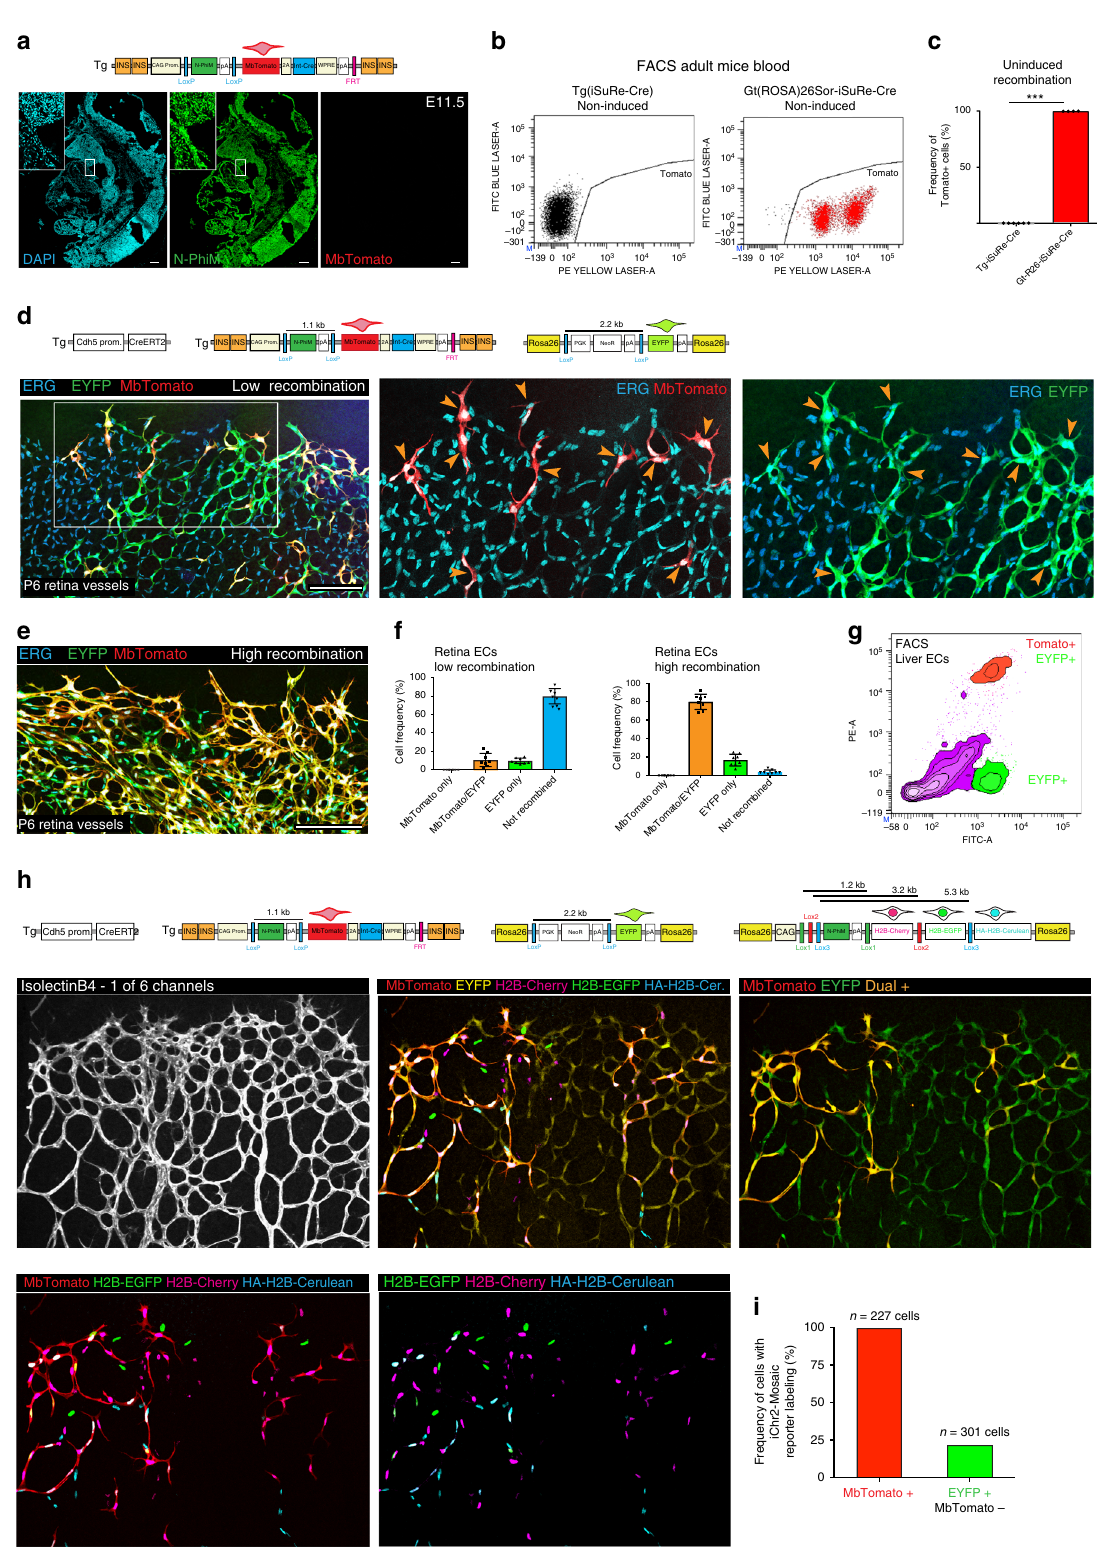
spontaneous deletion of these genes in a fraction of quiescent We next evaluated the relative inducibility rate of the Tg(iSuRe- Cre) allele by combining it with Cdh5-CreERT2 and other available Cre-reporter alleles, such as the Gt(ROSA)26Sor-LoxP-STOP-LoxP- EYFP allele (abbreviated here as ROSA26 LSL-EYFP ) 11 . At both low